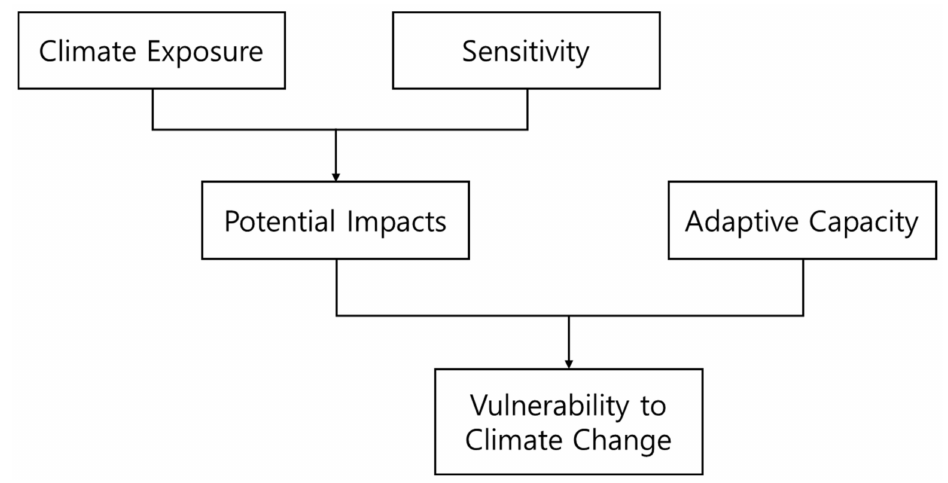
Figure 2. Schematic of climate change vulnerability [31].